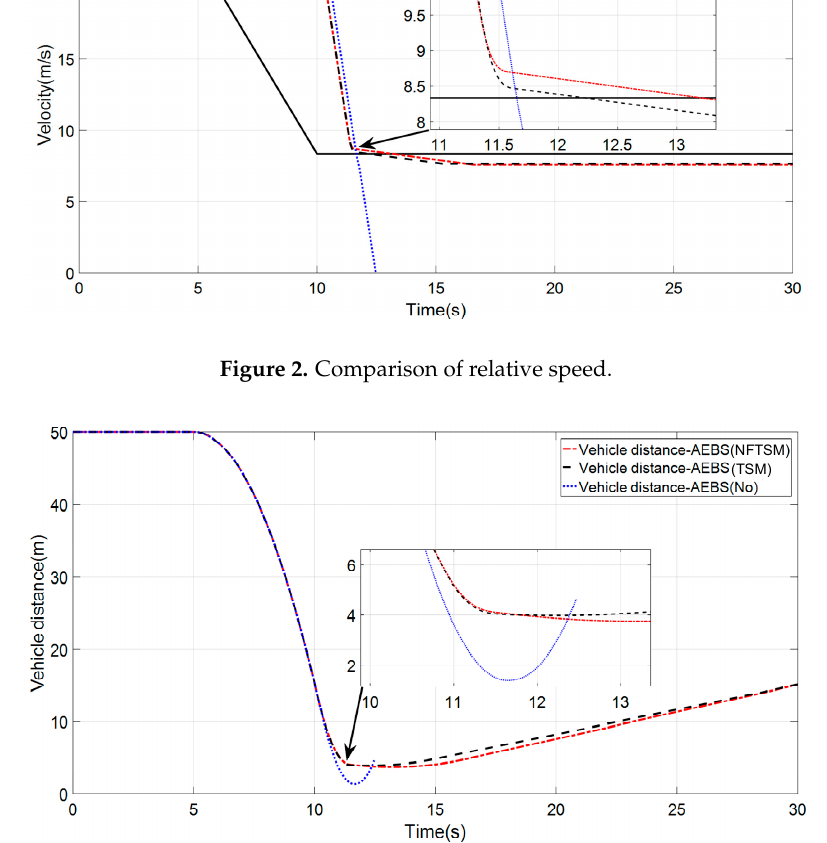
Figure 4. Comparison of vehicle acceleration.